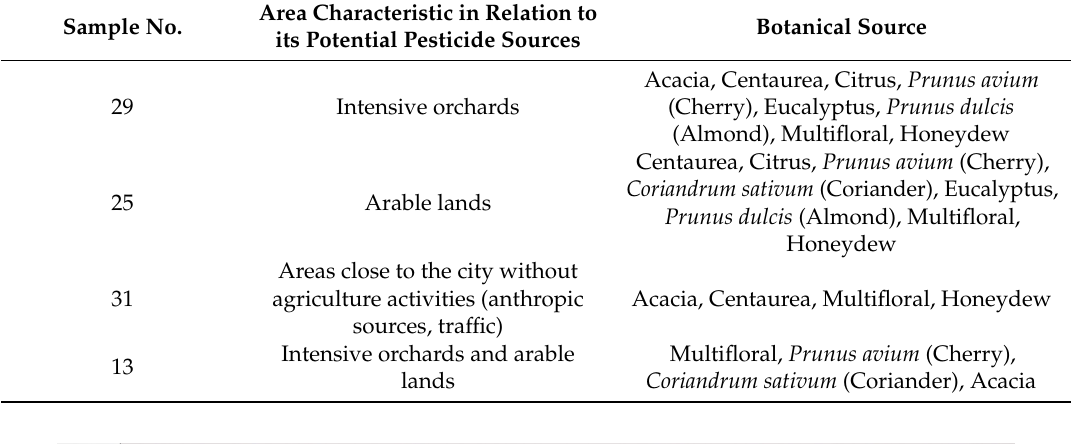
Table 1. Characteristics of the di ff erent production areas of the 98 collected honey samples. Sample No.